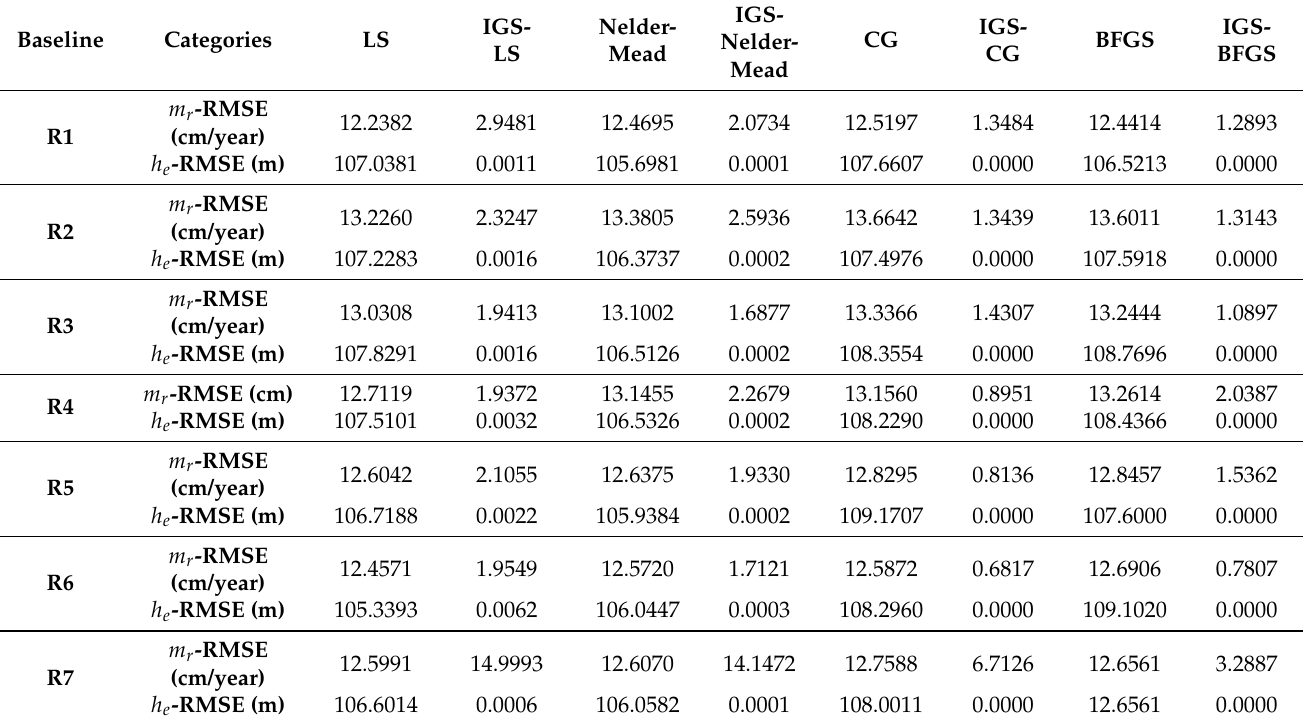
Table 2. Quantitative assessment for simulated data with several widely used local optimizers and their IGS-extended